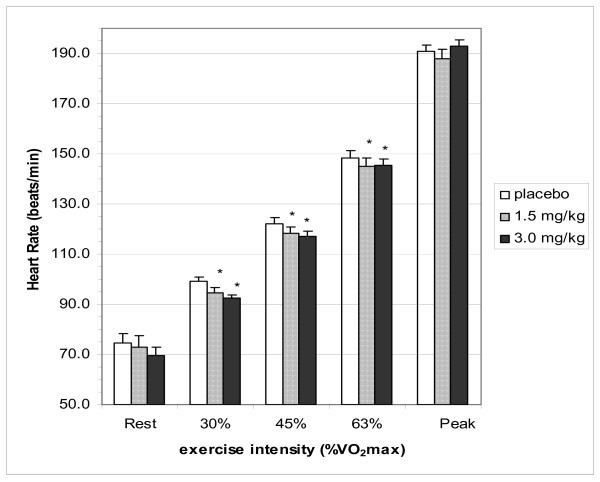
Heart rate at rest and during exercise. Differences in heart rate between placebo and caffeine trials. Placebo, 1.5 and 3.0 represent dose of caffeine in mg·kg body weight-1. Values are listed as mean ± SE. * = the mean difference compared to placebo is significant (p < 0.05).